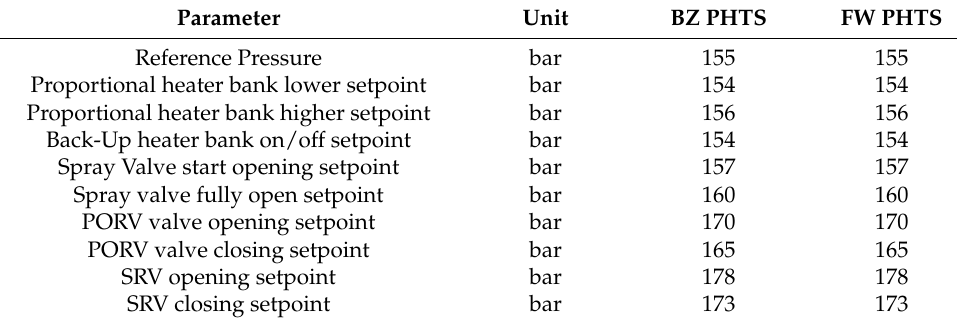
Table 3. BZ and FW PHTS pressure control function.